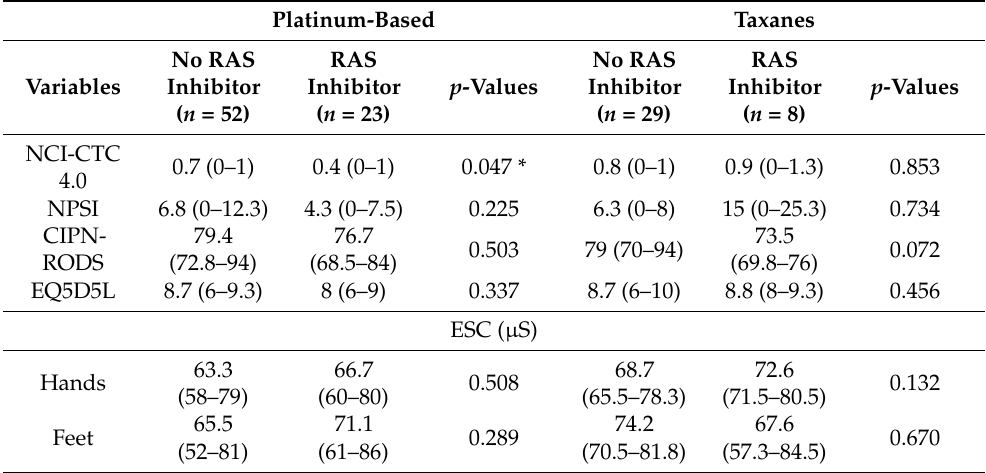
Table 3. Patient scores at the last follow-up, expressed as mean and interquartile